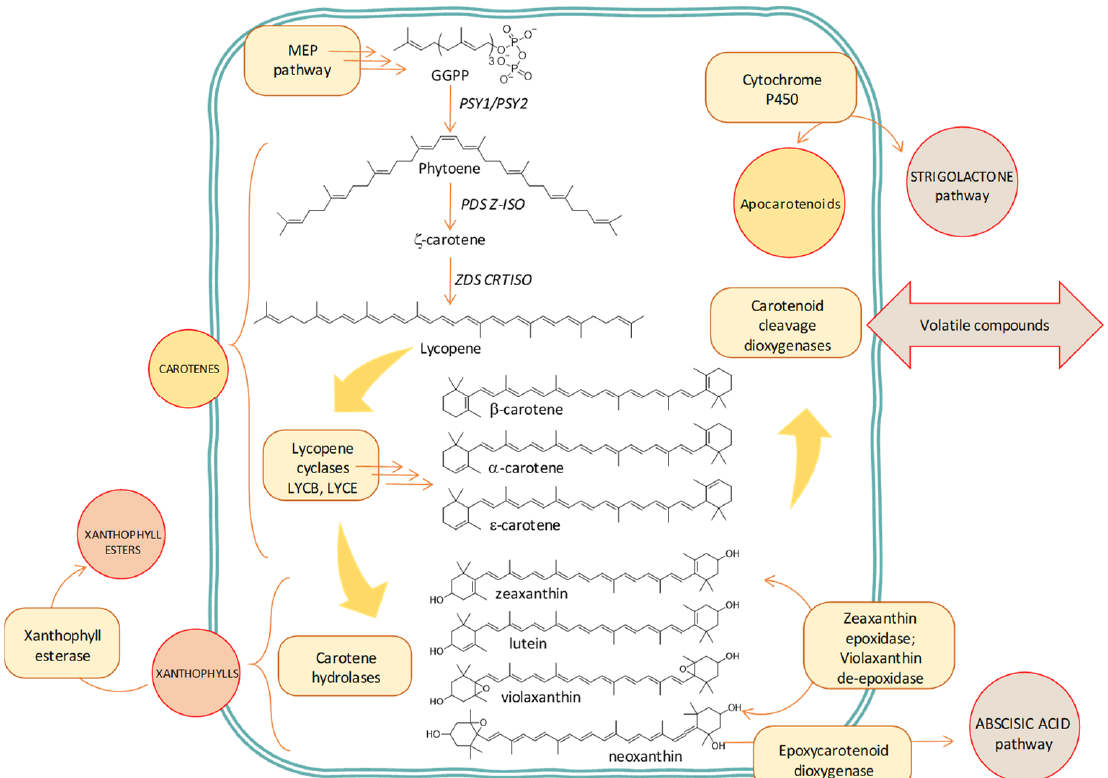
Figure 4. Scheme of the carotenoid biosynthesis route including catabolism to abscisic acid, volatile compounds, and strigolactones. MEP: methylerythritol phosphate; GGPP: geranylgeranyl pyrophosphate; PSY: phytoene synthase; PDS: phytoene desaturase; Z-ISO: ζ-carotene isomerase; ZDS: ζ-carotene desaturase; CRTISO: carotene isomerase.